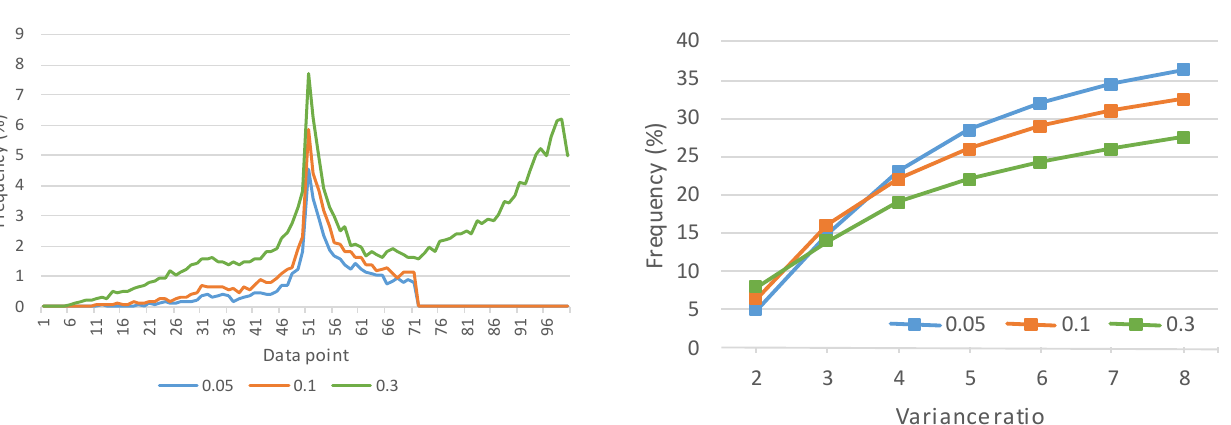
Figure 1. Frequency distribution of change points detected by SRSD ( p , 30, 2) for three different values of p : 0.05, 0.1, and 0.3. The true change point is c 1 = 51 and regime variances are = (1 , 2). σ 2 j